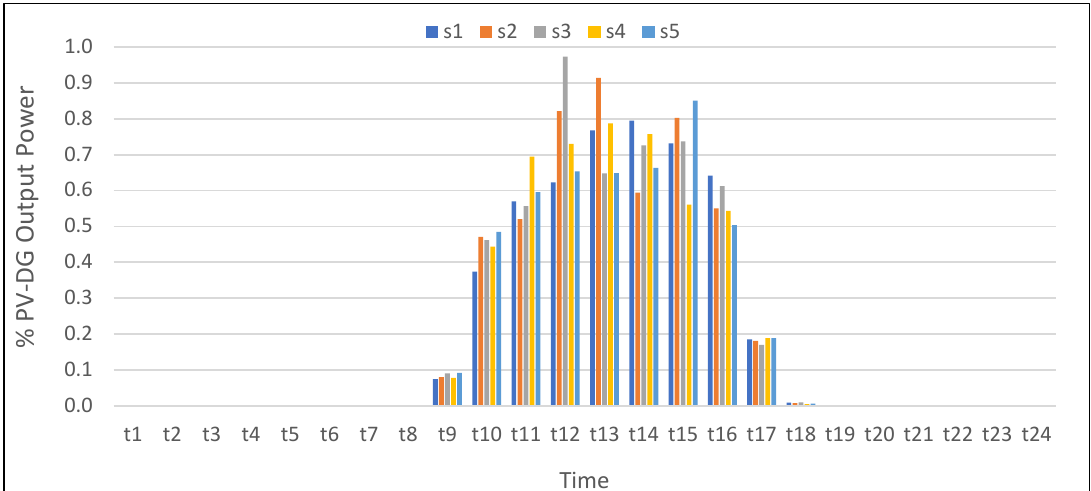
Figure 9. Daily output power profiles for Wind DG.